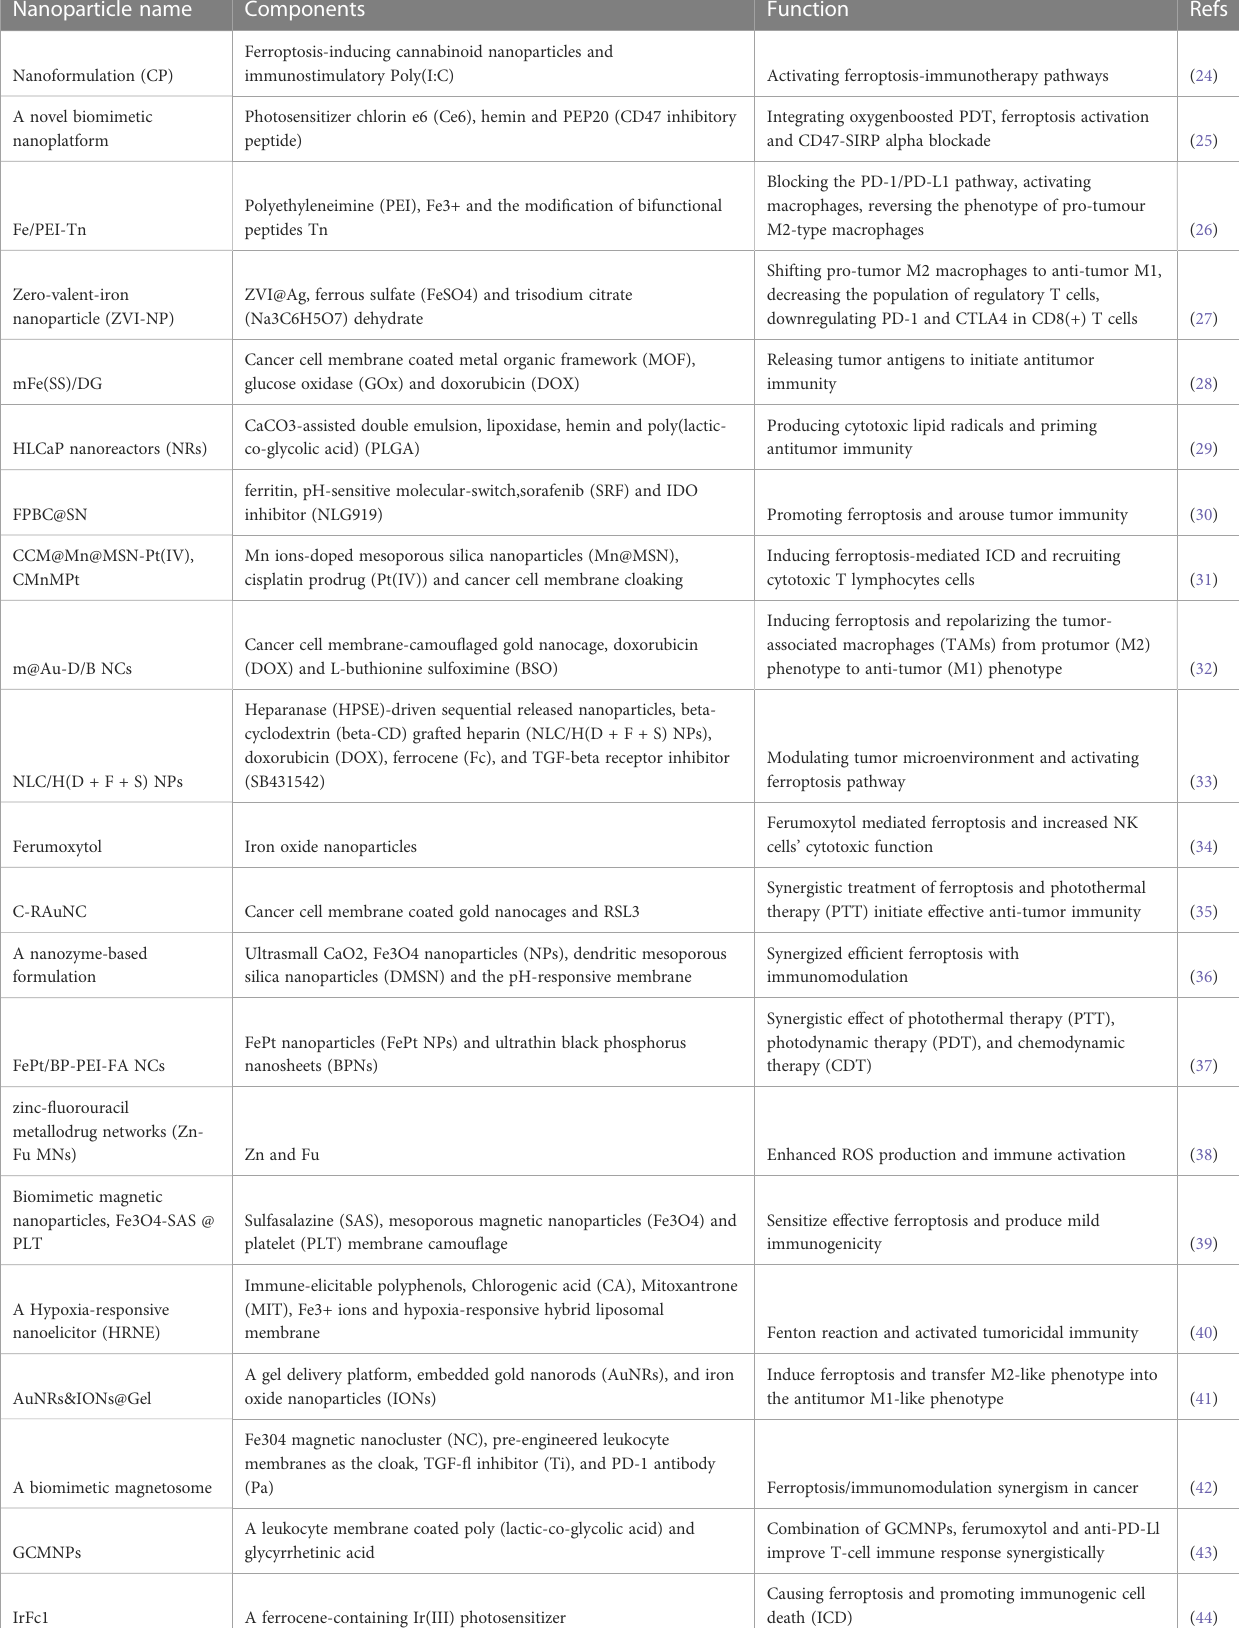
TABLE 5 Nanoparticles name, composition, and function of the 51